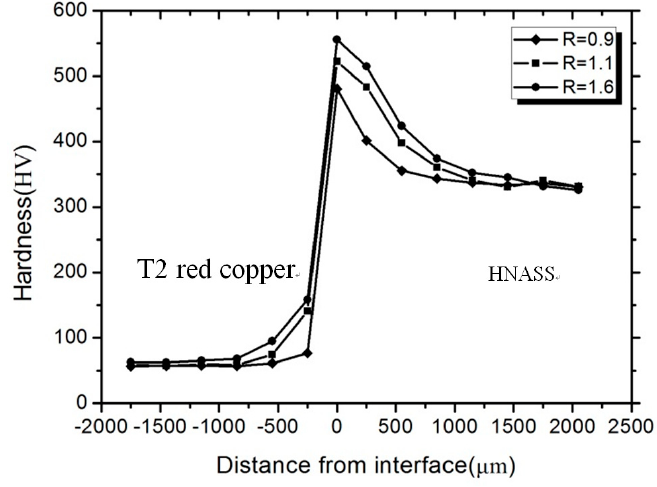
Figure 8. Microhardness values of T2 red copper/HNASS under different explosive welding parameter.